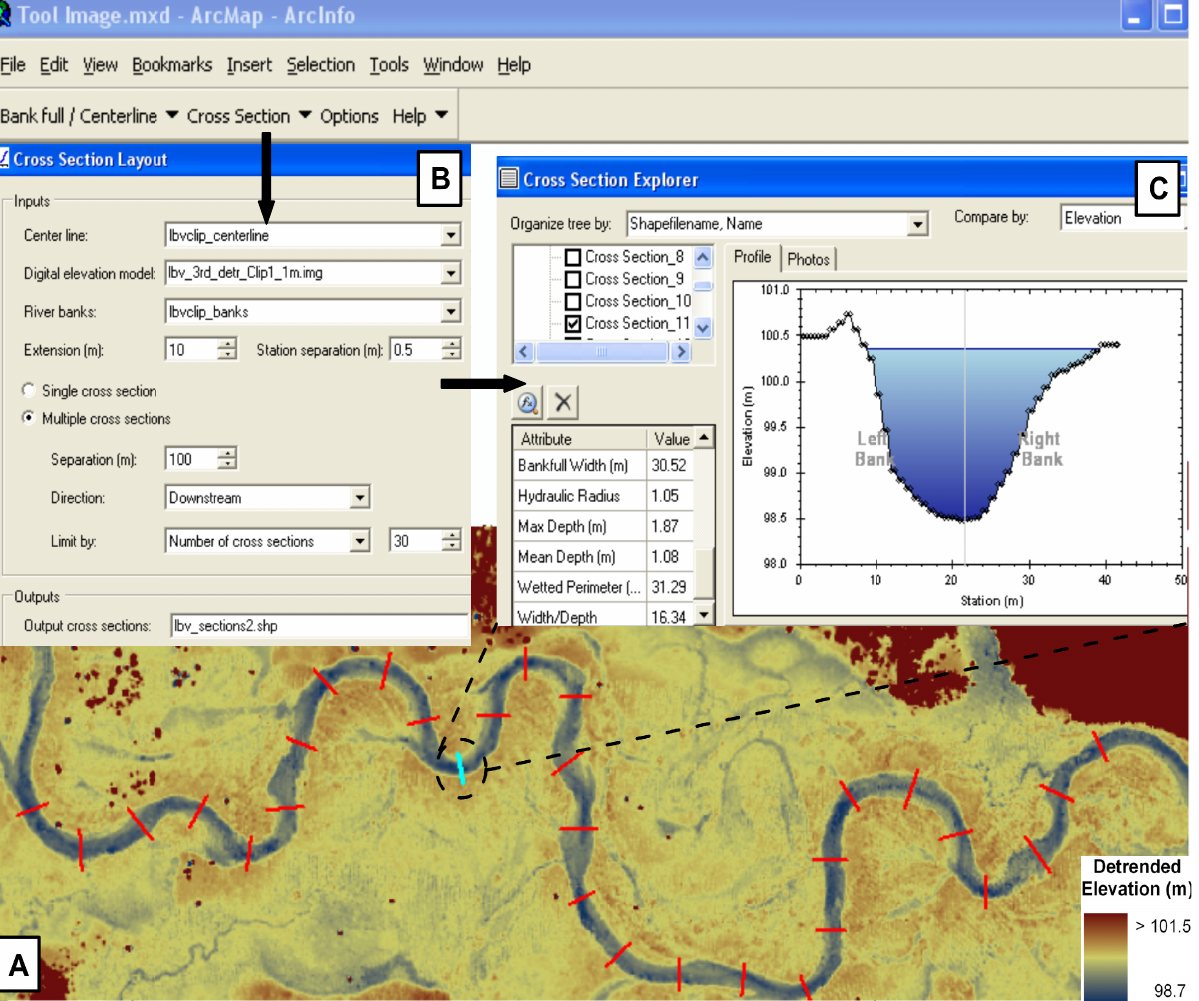
Figure 11. Bathymetric LIDAR Toolkit (BLT) graphical user interface. A) Detrended elevation raster with 1 m grid spacing. Flow is left to right. B) The Cross Section